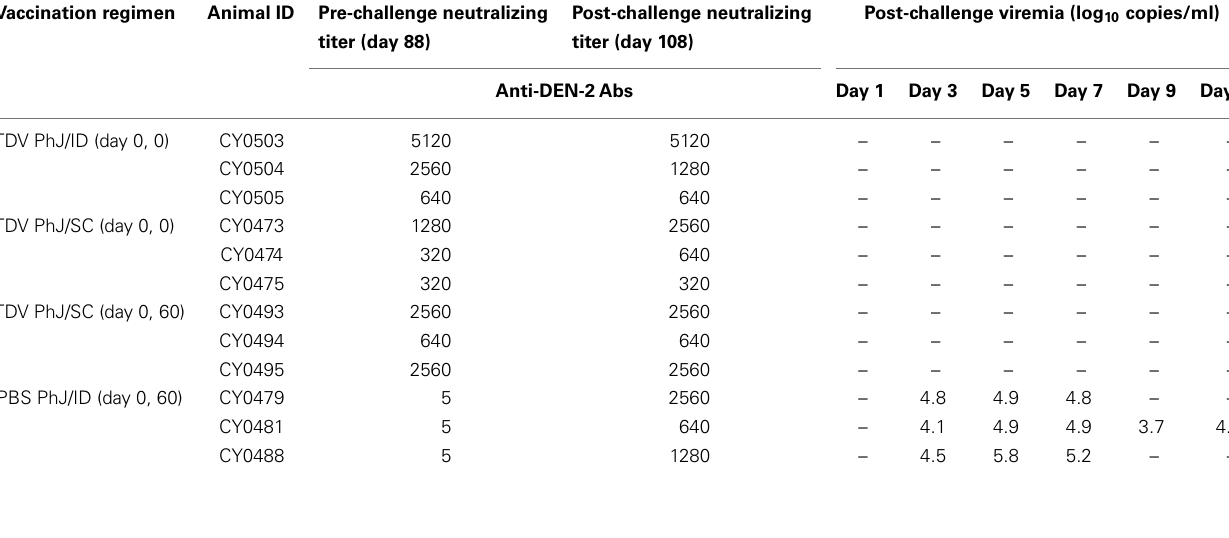
Table 5 | Protection ofTDV vaccinated NHPs from DENV-2 NGC challenge . Vaccination